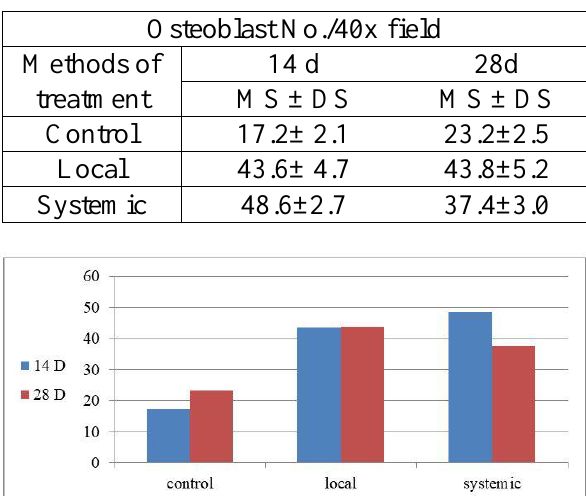
Table I: Statistical analysis of the number of osteoblasts: Osteoblast No./40x field